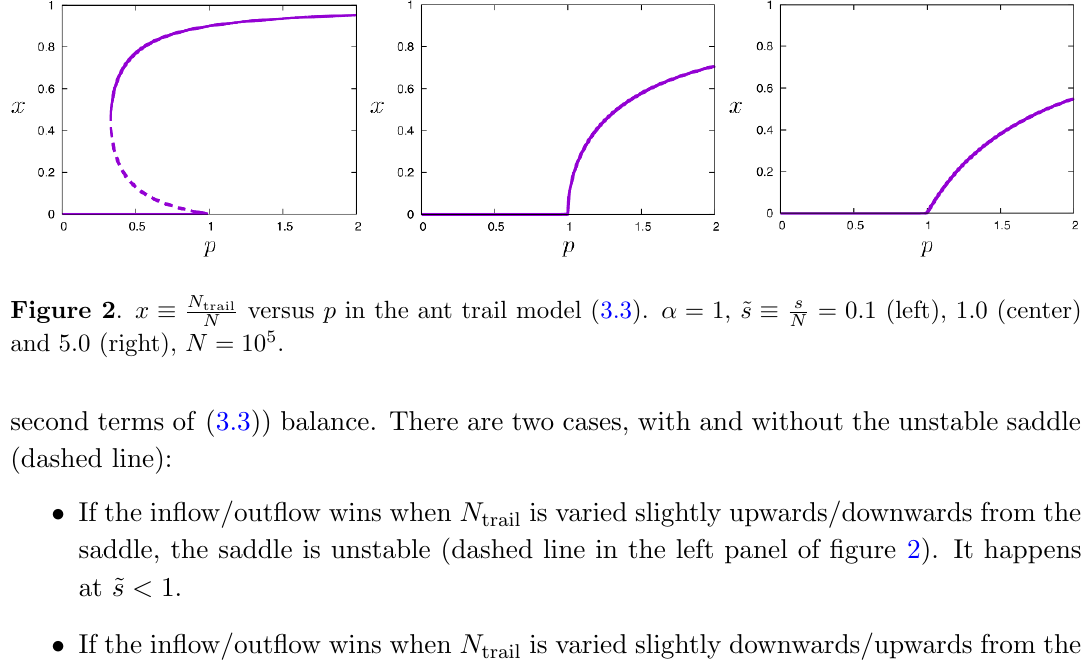
= 0 : 1 (left), 1 : 0 (center) N